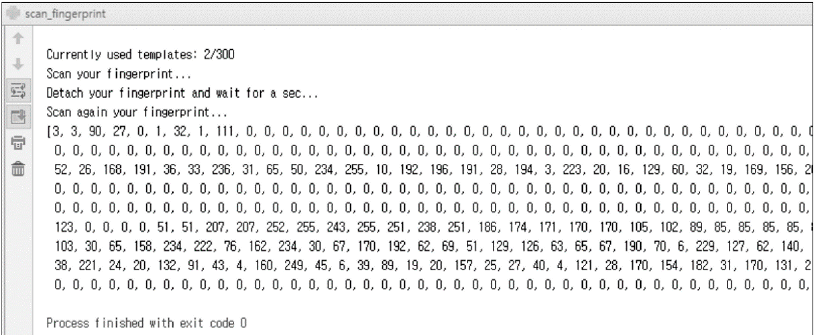
Figure 12. Characteristic of Scanned Fingerprint.